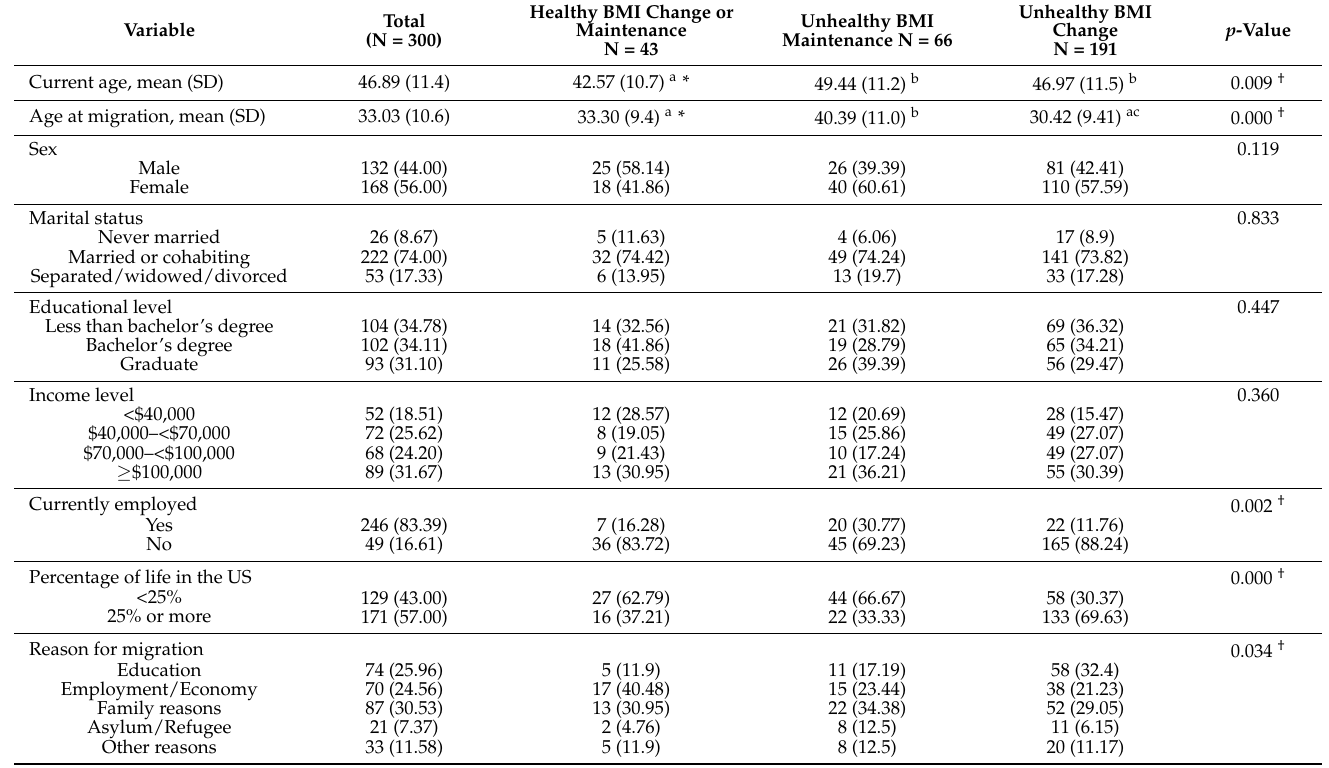
Table 1. Demographic characteristic of participants (N =